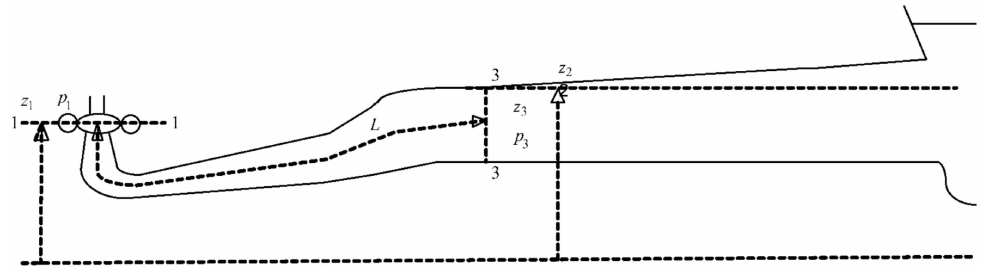
Figure 5. Schematic diagram for the profile of an SCTT